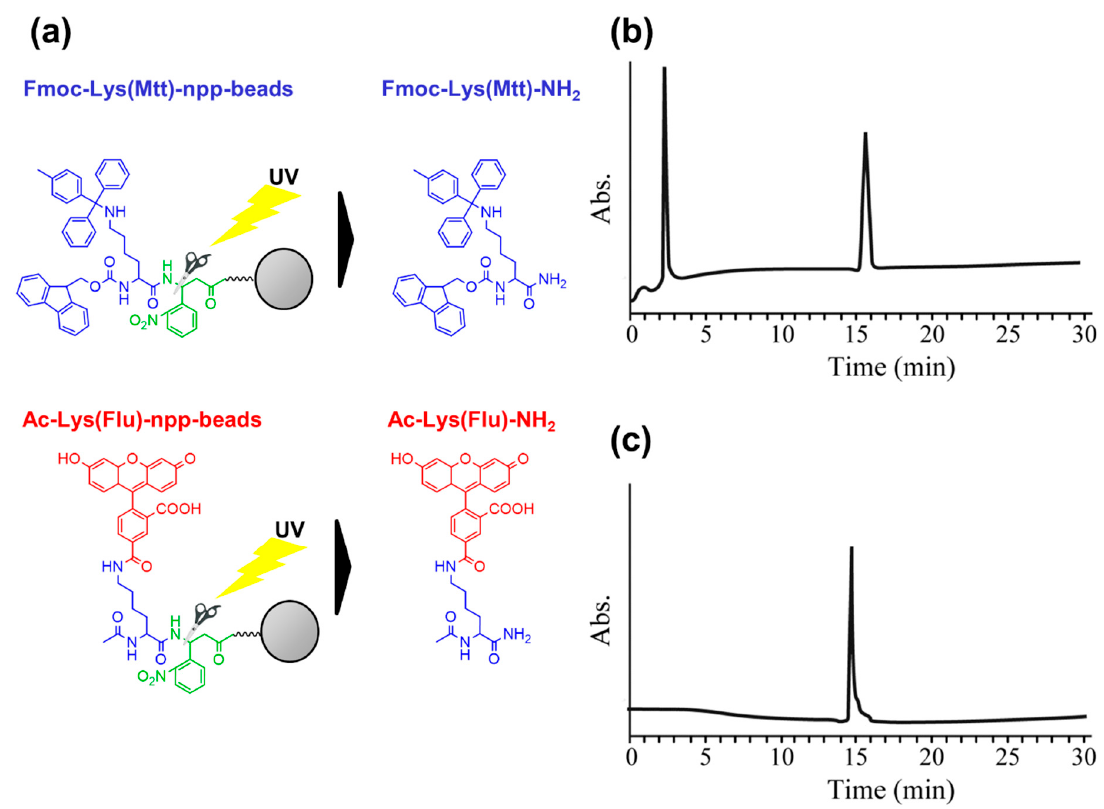
Figure 2. ( a ) Release of Fmoc-Lys(Mtt)-NH 2 and Ac-Lys(Flu)-NH 2 from the magnetic beads. HPLC chromatographs of Fmoc-Lys(Mtt)-NH 2 ( b ) and Ac-Lys(Flu)-NH 2 ( c ). HPLC was performed using an Inertsil ODS-3 column (4.5 × 150 mm) for analysis with a linear gradient from 0% to 100% of solvent B (90% acetonitrile, 10% Milli-Q water, and 0.08% trifluoroacetic acid (TFA)) over 30 min at a flow rate of 1.0 mL / min. The eluate was monitored at 301 nm for Fmoc moiety absorbance of Fmoc-Lys(Mtt)-NH 2 or at 492 nm for fluorescein moiety absorbance of Ac-Lys(Flu)-NH 2 .